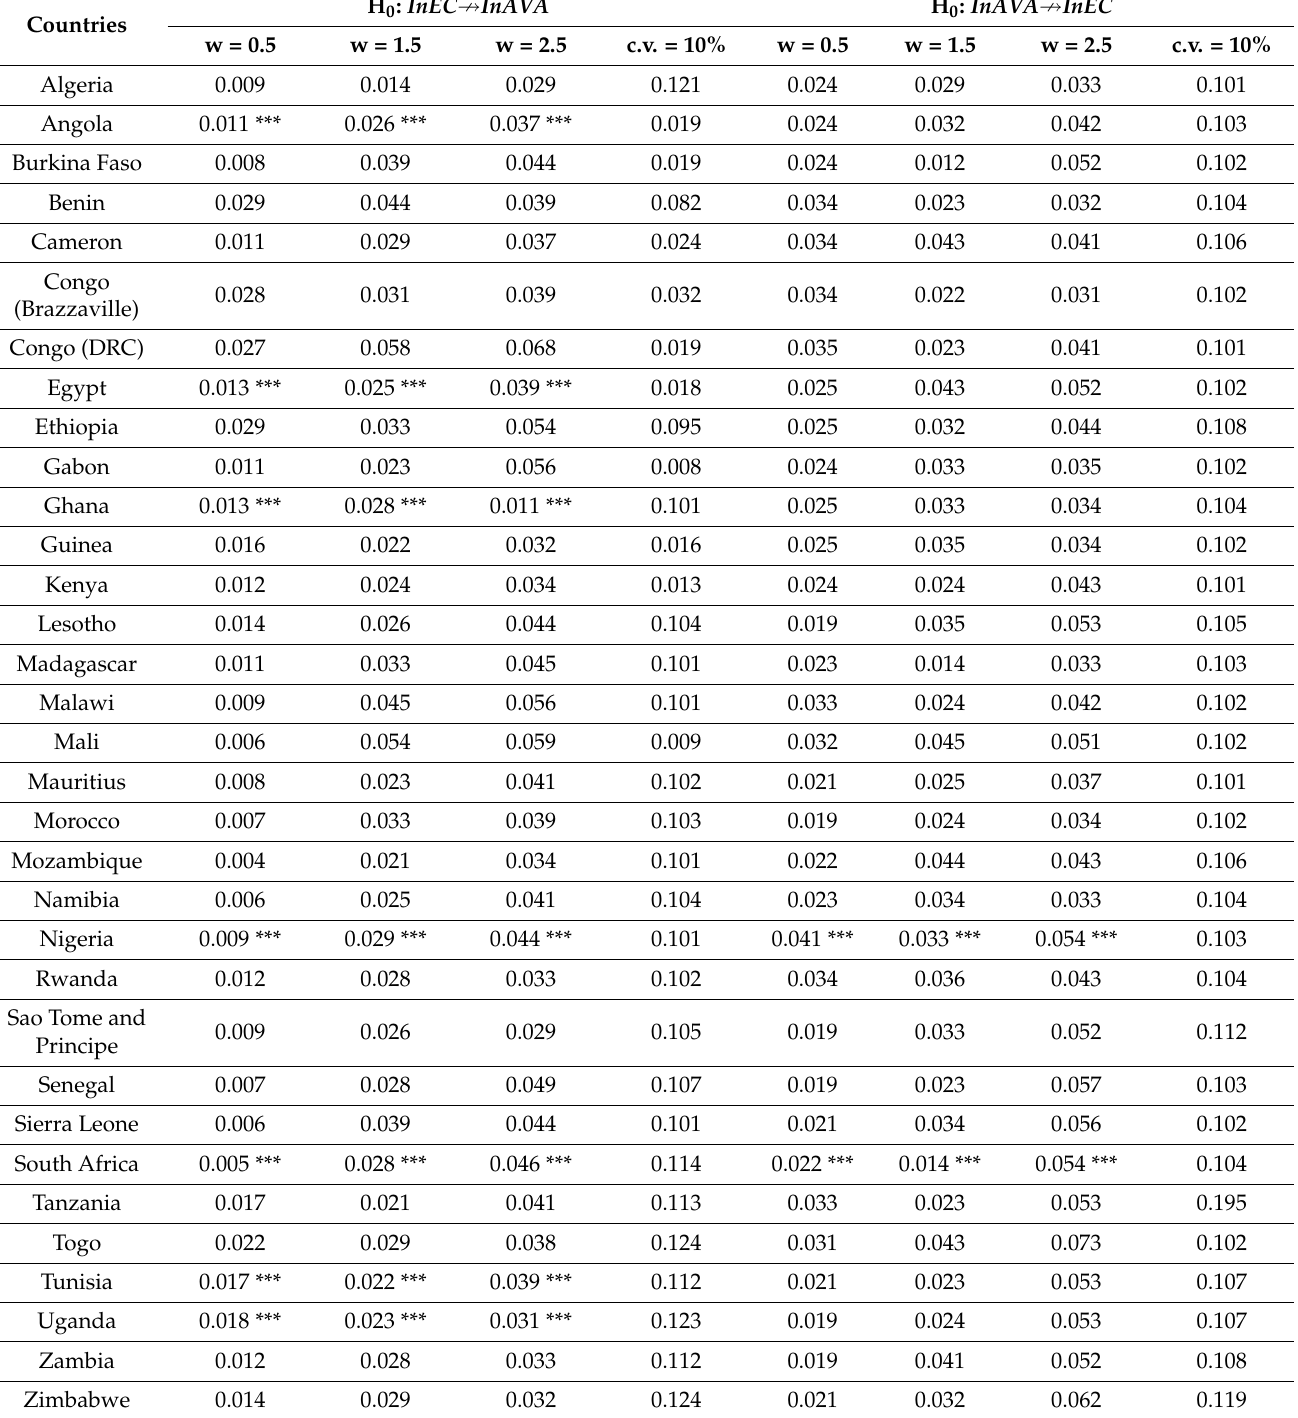
Table 9. Granger causality tests in the frequency domain estimates InEC , InAVA